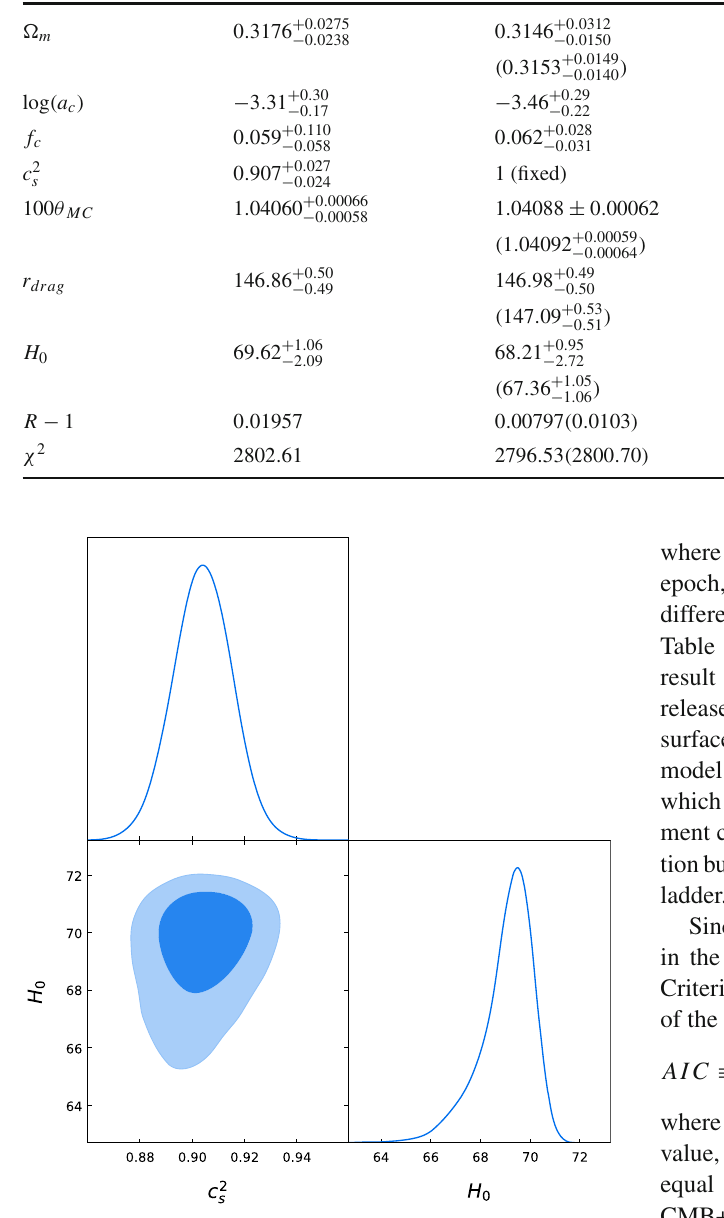
Fig. 1 One and two-dimensional distributions of c 2 s and H 0 in Planck dataset, where the contour lines represent 68% and 95% CL, respec-